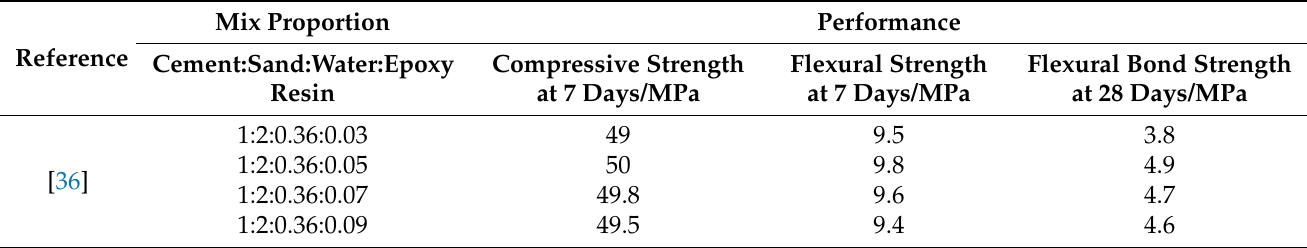
Table 8. Properties of the epoxy-modified cement mortar as repair